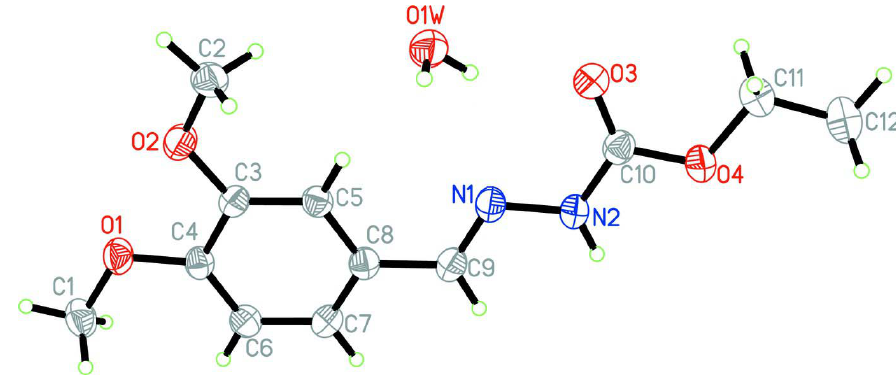
Figure 1 Molecular structure of (I), showing 30% probability displacement ellipsoids and the atomic numbering. (E)-Ethyl N ′ -(3,4-dimethoxybenzylidene)hydrazinecarboxylate